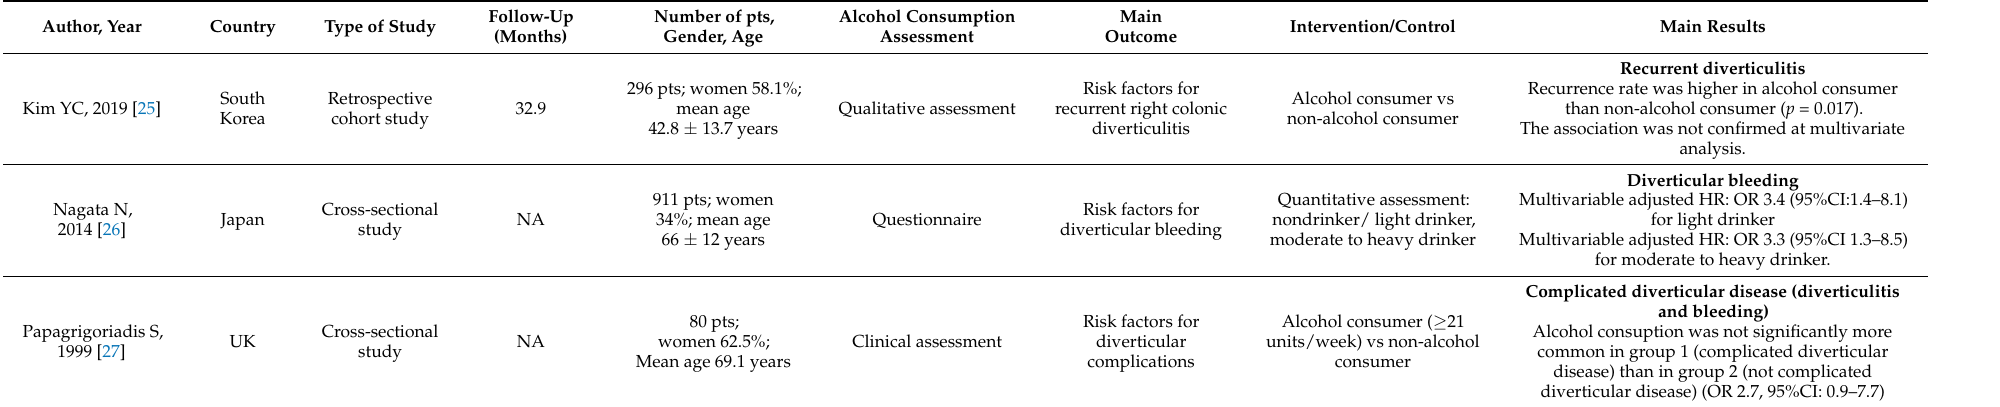
Table 2. Effect of alcohol consumption in the prevention of acute diverticulitis and diverticula